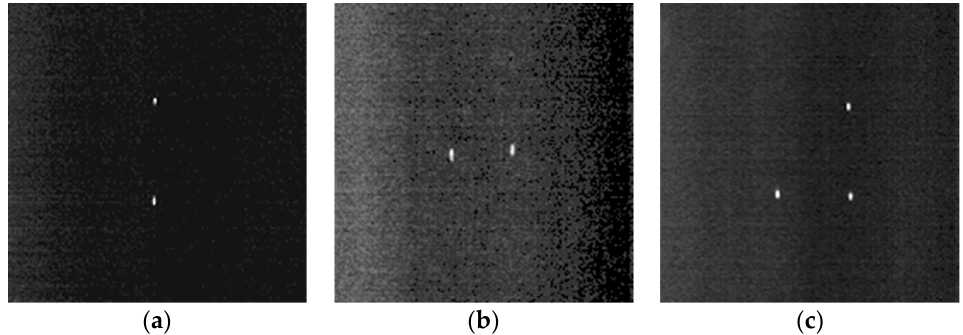
Figure 1. Video frames of different particle configurations in the lower stratum of a glow DC discharge at a buffer gas pressure of 2 Pa and a current of 0.75 mA. ( a ) Vertical alignment of two particles before the laser perturbation (we assign the index “1” to the lower particle and “2” to the upper one); ( b ) particles in the horizontal plane after the laser action on the lower particle; ( c ) stable configuration of three particles.